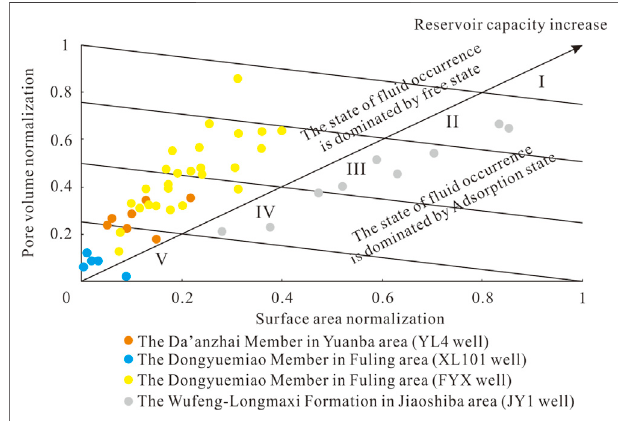
FIGURE 11 | Reservoir capacity of continental shale reservoirs in the northeastern Sichuan Basin (JY1 well data by the Guo et al., 2014; FYX well data by the